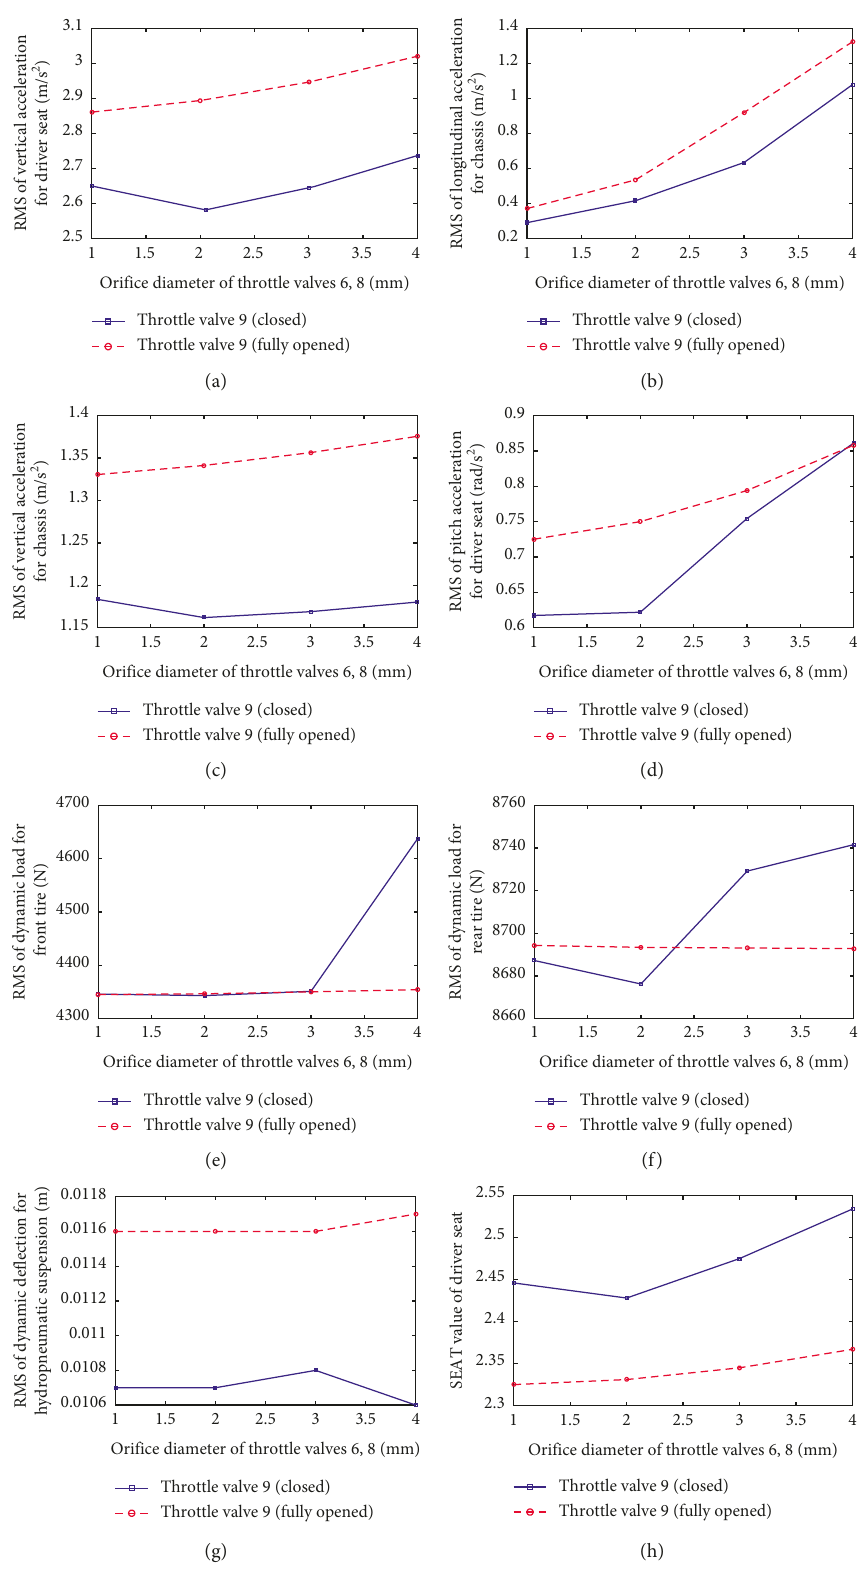
Figure 15: RMS of vibration responses of tractor system under different orifice diameters of throttle valves: (a) vertical acceleration of the driver seat; (b) longitudinal acceleration of the chassis; (c) vertical acceleration of the chassis; (d) pitch acceleration of the chassis; (e) dynamic load of the front tire; (f) dynamic load of the rear tire; (g) dynamic deflection of the hydropneumatic suspension; (h) SEATvalue of the driver